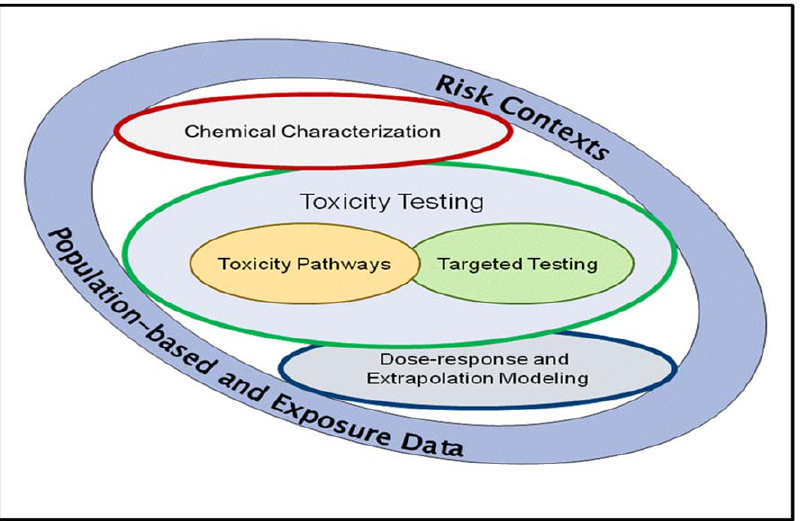
Figure 1. Schematic of components required to implement the new vision of toxicity testing in the 21 st century ( needspermission fromNRCTT21Creport ). The core components of the TT21C vision relate to testing for biological activity of compounds in toxicity pathway assays and to dose-response and extrapolation modeling using computational systems biology and pharmacokinetic tools. In the period of transition from current practice to the new vision some targeted testing in animals might be required. Targeted testing might also allow evaluation of target pathways and identification of metabolites. Assessing likely metabolism remains a challenge for the full implementation of the TT21C vision.